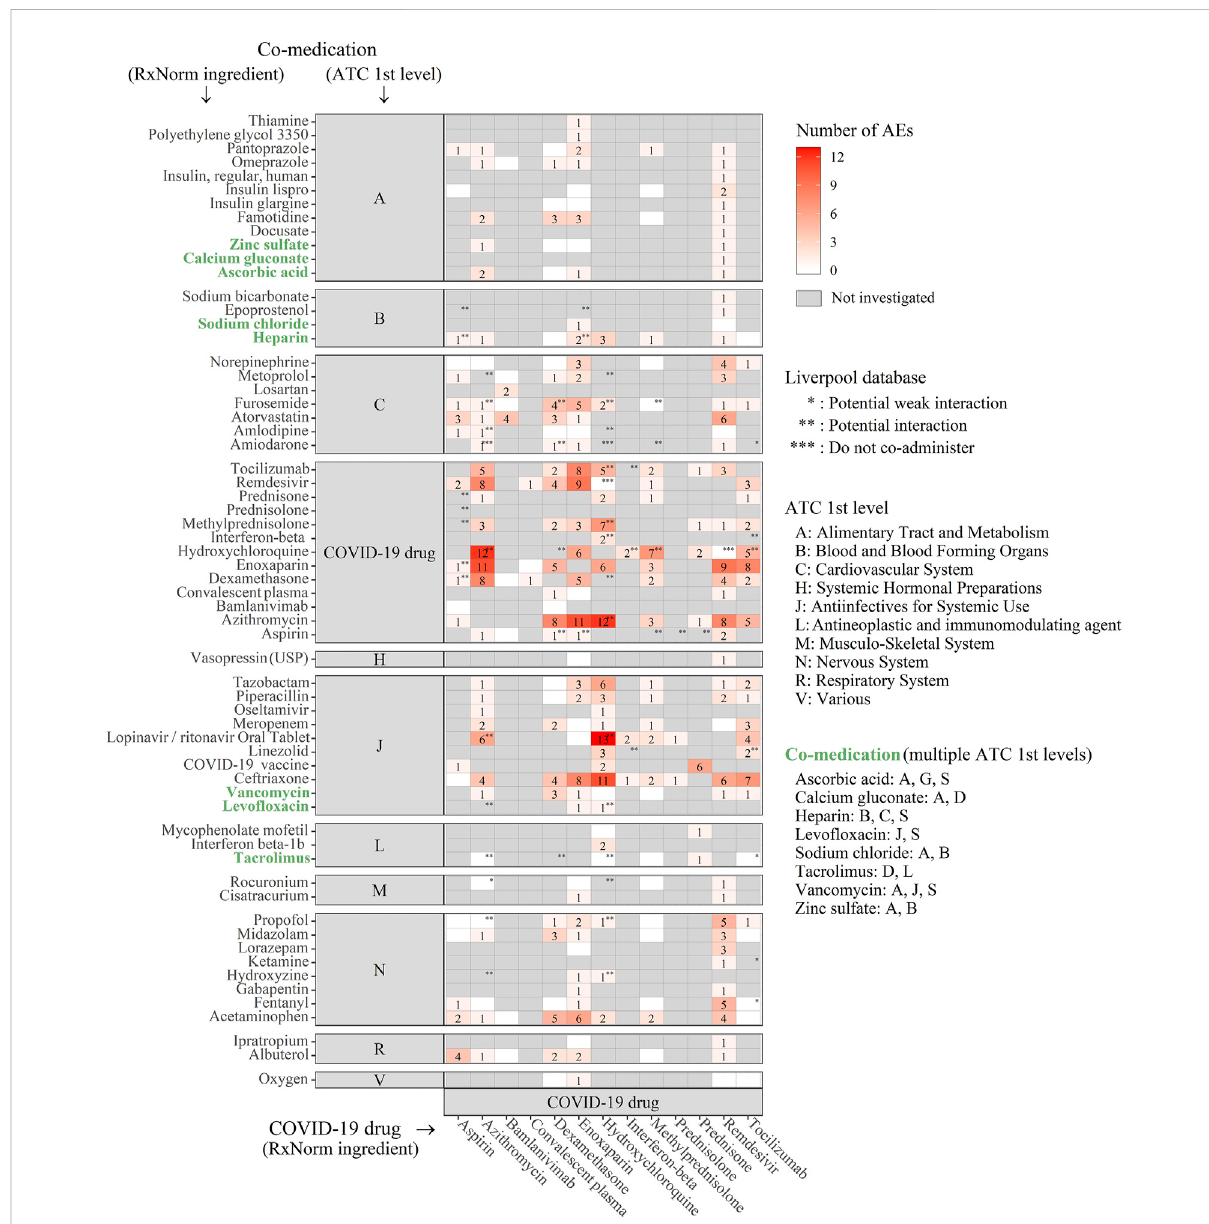
FIGURE 4 Heatmap depicting statistically signi fi cant associations between the COVID-19 drugs (on the bottom) and the co-medications (clustered by ATC1stlevel,ontheleft).Thecellswerecolored whitetoredaccordingtothenumberofAEspresent(greyiftherewasinsuf fi cientdataintheFAERS database to investigate associations). Asterisks were used to denote the DDIs in the Liverpool database (*: potential weak interaction, **: potential interaction, and ***: do not